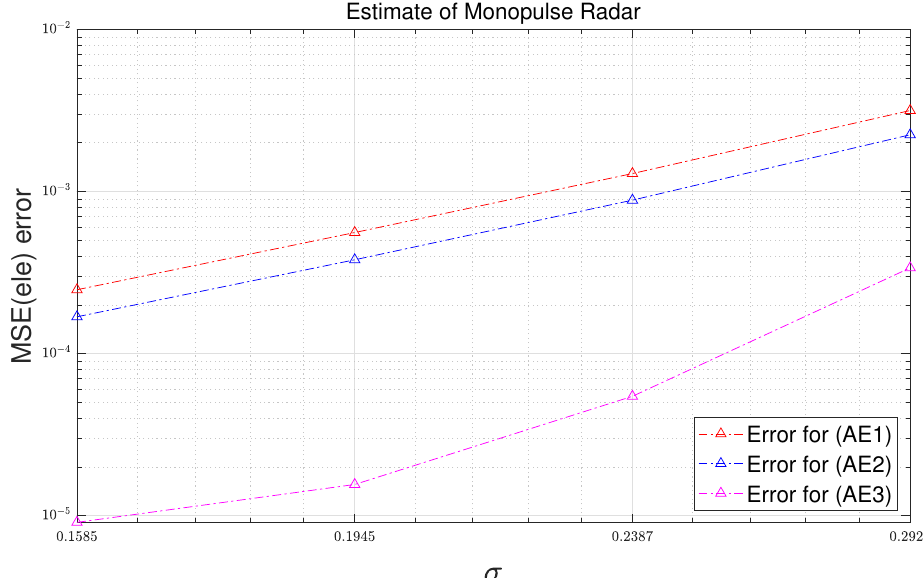
Figure 12. Elevation MSE errors of analytic MSE as function of standard deviation.